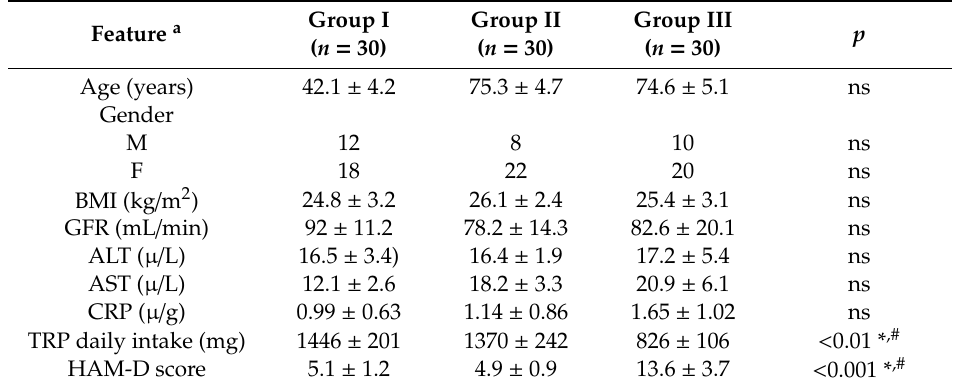
Table 1. Characteristics of the subjects enrolled in this study: group I, controls; group II, elderly subjects; group III, elderly patients with mood disorders.